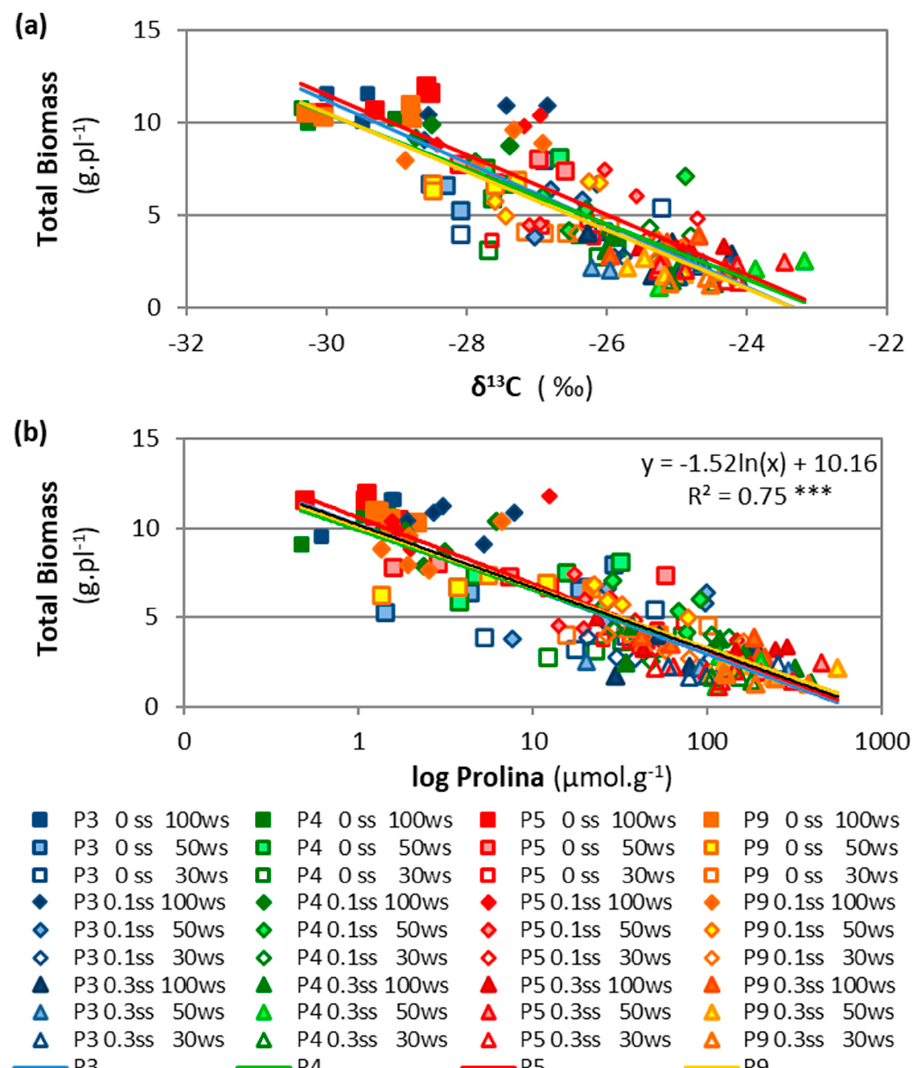
Figure 6. Relationship between total biomass and stable isotope of carbon ( δ 13 C) ( a ) or free proline ( b ) for four accessions (P3, P4, P5, P9) grown under three drought levels (0 WS, 50 WS, or 70 WS, corresponding to 100%, 50%, or 30% water capacity, respectively) combined with three salinity levels (0 SS, 0.1 SS, or 0.3 SS, corresponding to 0.0, 0.1, or 0.3 M NaCl, respectively). Colored lines show the behavior of each accession. For δ 13 C, P3: y = − 1.75x − 41.30 R 2 = 0.69 ***, P4: y = − 1.61x − 37.64 R 2 = 0.76 ***, P5: y =